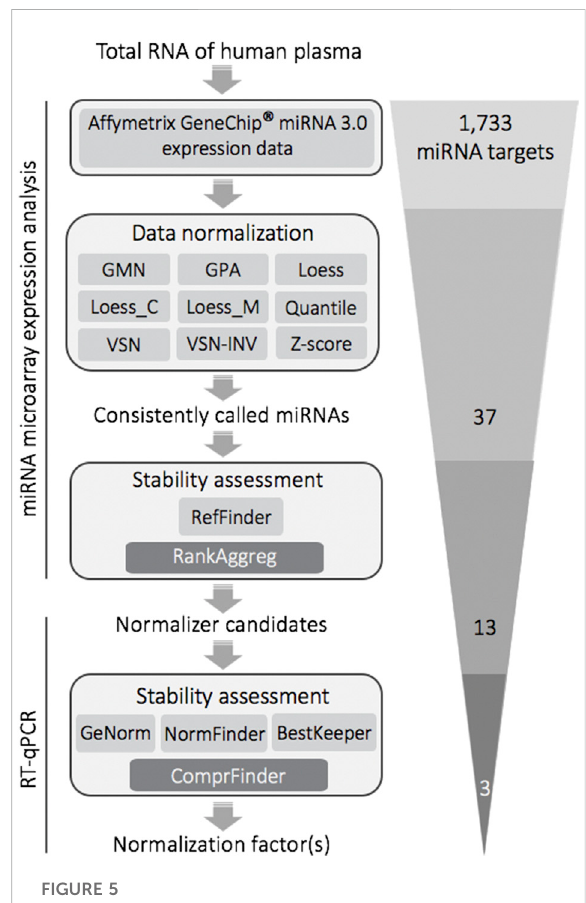
FIGURE 5 Selection and validation of stable reference miRNAs for RT- qPCR-basedquantitativeexpressionanalysisofplasmadonatedby human males differing in cognitive stress coping styles: methodological fl ow chart and fi ltering steps. The fi nal trio of stablemiRNAswascomposedofmiR-320d,miR-4787-5p(duo NF for plasma of Caucasian males) and miR-425-5p (composing the duo NF together with miR-4787-5p when plasma samples were strati fi ed into cognitive avoidant or vigilant copers). Abbreviations: GMN, Global Mean Normalization; GPA, Generalized Procrustes Analysis; Loess, locally estimated scatterplot smoothing; Loess_C, CyclicLoess;Loess_M,Modi fi edLoess;VSN,VarianceStabilization Normalization; VSN-INV, VSN based on invariant miRNAs; Z-score, Z-Score Normalization; RefFinder, comprehensive analysis of stability based on the common statistical algorithms geNorm, NormFinder, BestKeeper, and Δ Ct method; RankAggreg, software package for weighted rank aggregation; ComprFinder, comprehensive stability ranking algorithm based on weighted